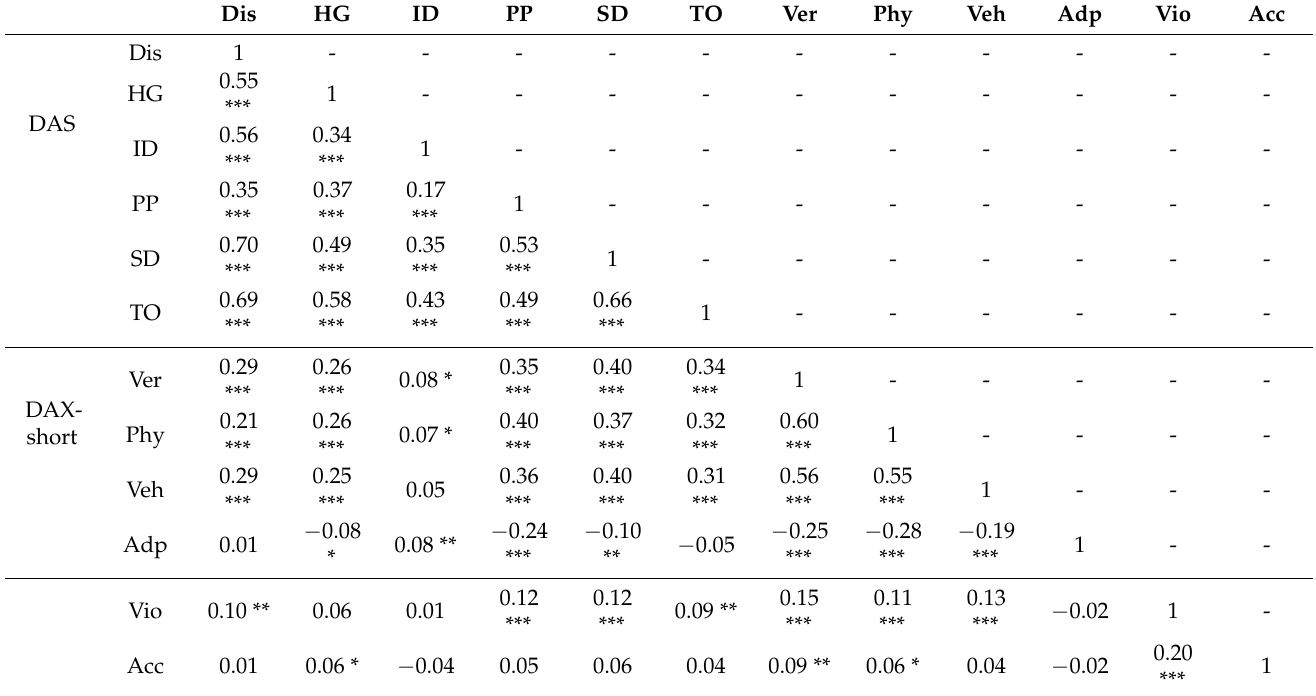
Table 6. Spearman’s correlation coefficients among study variables (N =